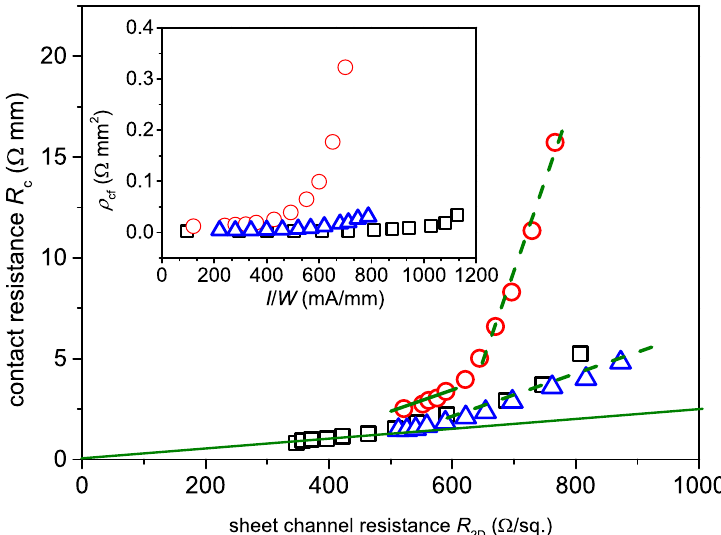
Figure 9. The dependence of the contact resistance R c on the channel sheet resistance R 2D for different samples; AlGaN/GaN (squares), AlGaN/AlN/GaN (triangles and circles). Lines illustrate the slopes of the dependencies. Starting at R 2D ∼ 750 Ω /sq., the increase in R c becomes faster (dashed lines versus solid